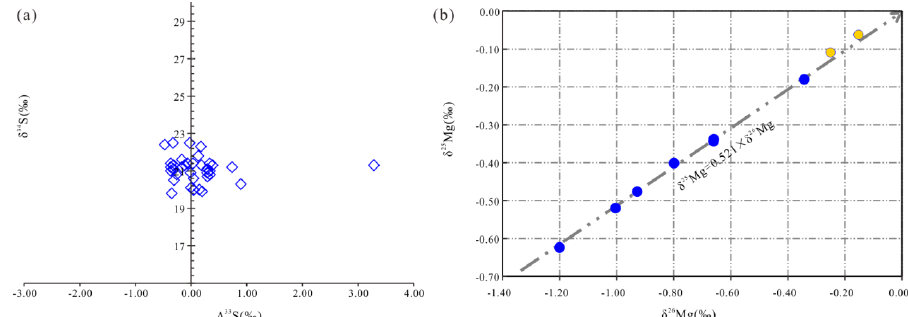
Figure 7. ( a ) Plot of δ 34 S versus Δ 33 S for the anhydrite and gypsum in the Zhaoanzhuang iron deposits. ( b ) Ternary magnesium isotope diagram of all of the samples (blue solid circles) and reference standards (yellow solid circles) analyzed in this study. The dashed line is the mass-dependent fractionation line with a slope of 0.521.